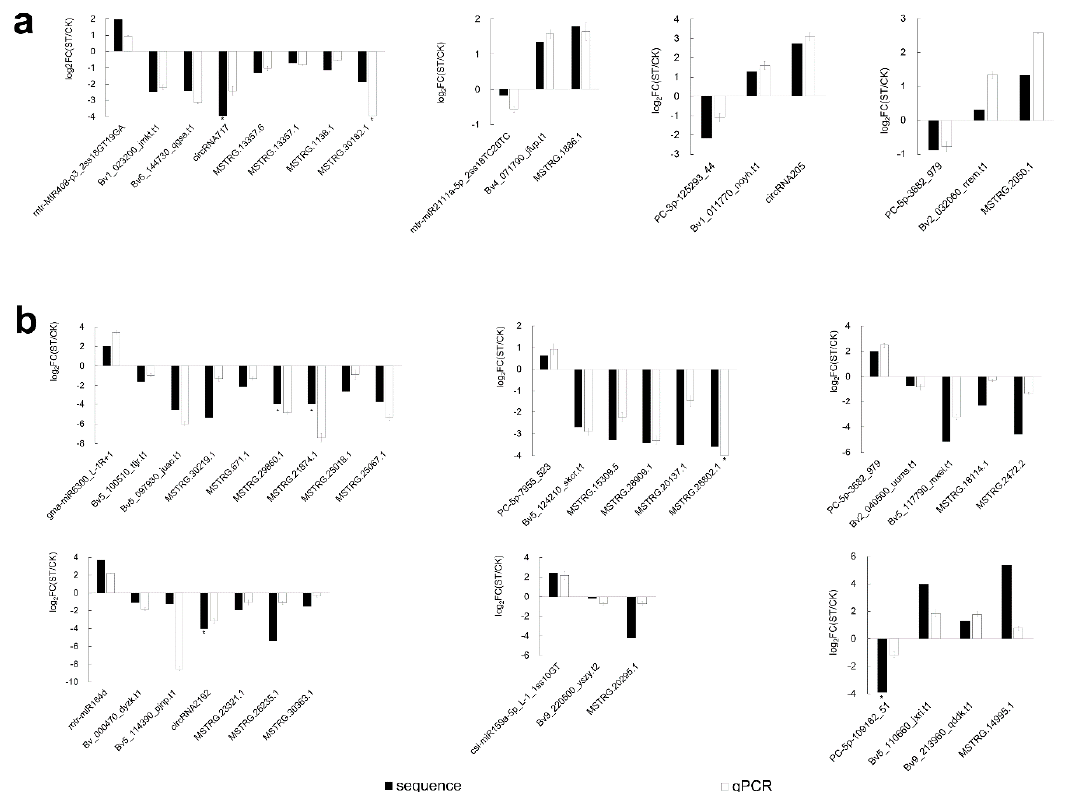
Figure 7. qRT-PCR analysis of all 50 components of the ceRNA network under salt stress in ( a ) leaves and ( b ) roots. FC(ST/CK) represents fold changes of relative expression levels between ST and CK, log2FC(ST/CK) is from the mean of three replicates, bars stand for ±SD, asterisk (*) indicates that the gene is not detected in ST and its value is artificially set to − 4 instead of calculating log2(0).